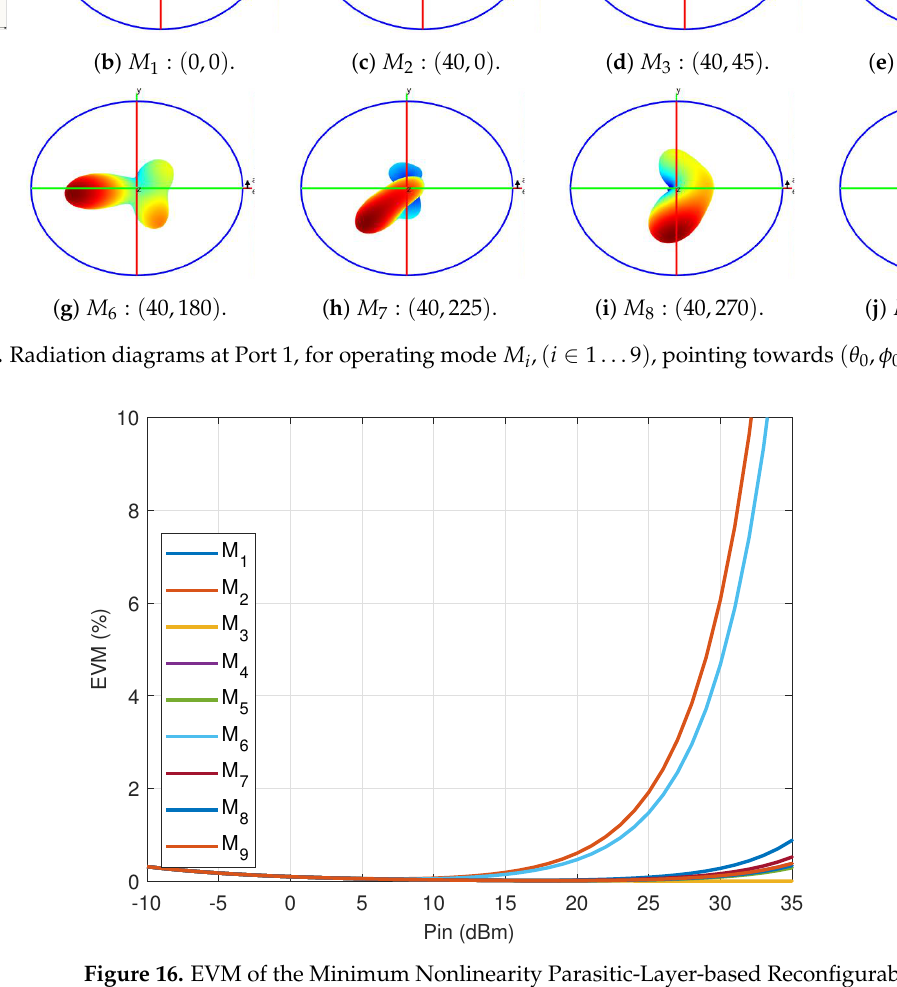
Figure 16. EVM of the Minimum Nonlinearity Parasitic-Layer-based Reconfigurable Antenna.